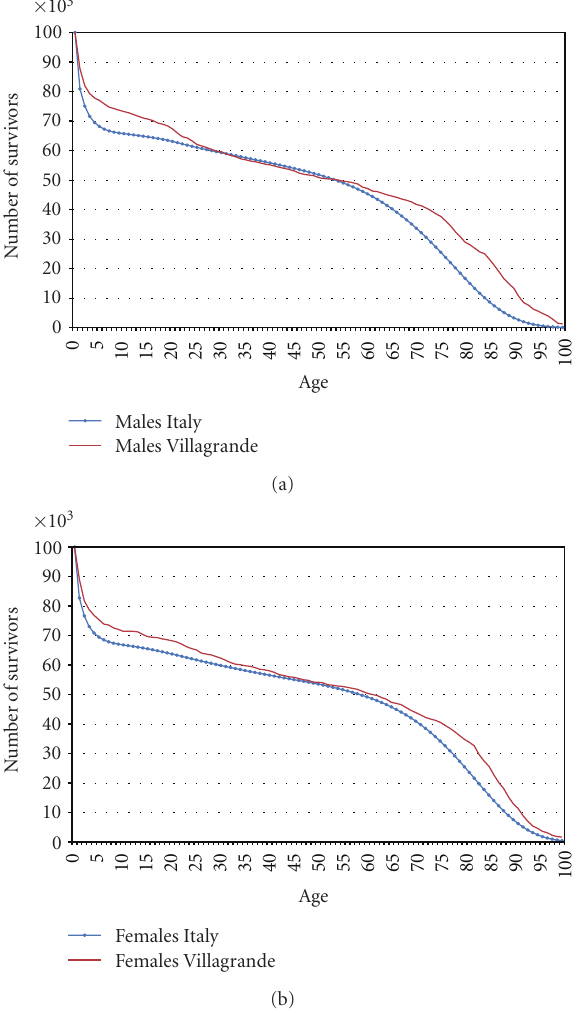
Figure 2: (a) Comparison of survival curves for males in Villa- grande with the corresponding data extracted from the Human Mortality Database for the whole of Italy (birth cohorts from 1876 till 1912 included). (b) Comparing survival for females in Villagrande with strictly comparable data extracted from the Human Mortality Database for the whole of Italy (birth cohorts from 1876 till 1912